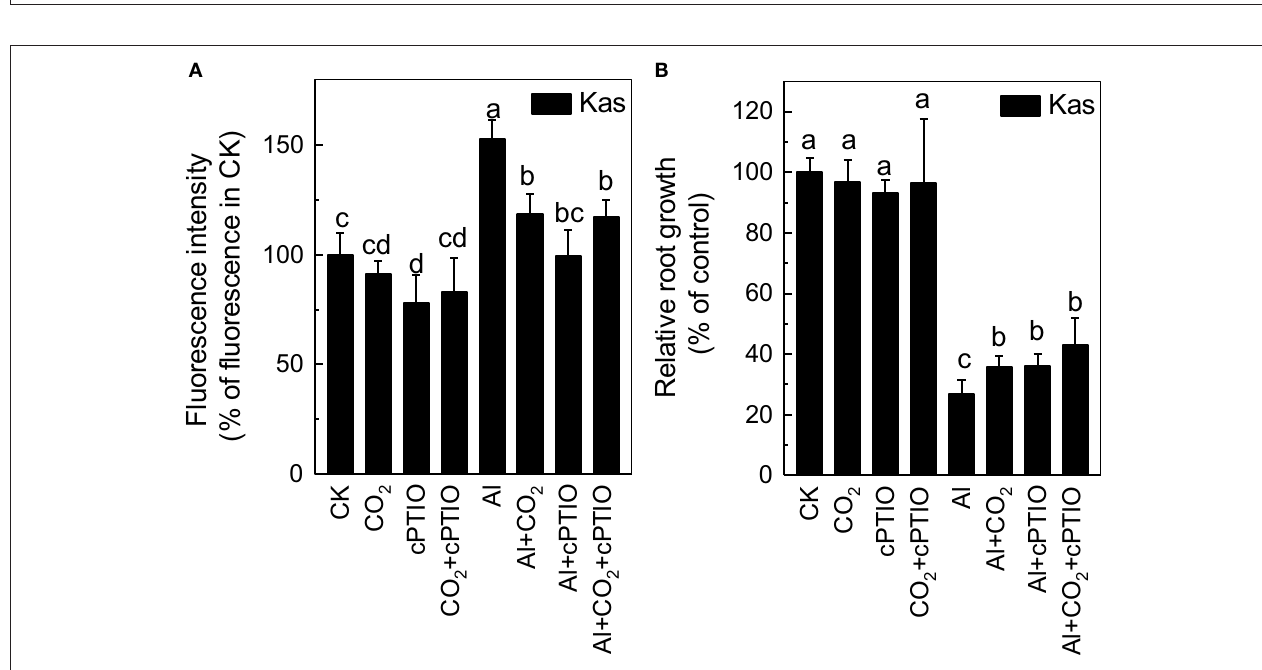
FIGURE 7 | Effects of elevated CO 2 treatment on the NO production in Kas. Three-day-old rice seedlings were treated with 0.5 mM CaCl 2 solution with or without 50 µ M Al under ambient (400 µ L · L − 1 ; CK) or elevated (600 µ L · L − 1 ; CO 2 ) CO 2 for 24 h (pH 4.5). (A) Photographs of NO production shown as green fluorescence in representative roots and (B) NO production expressed as relative fluorescence intensity (% of control). Data are means ± SD ( n = 10). Scale bar = 1 mm. Columns with different letters are significantly different at P < 0.05.